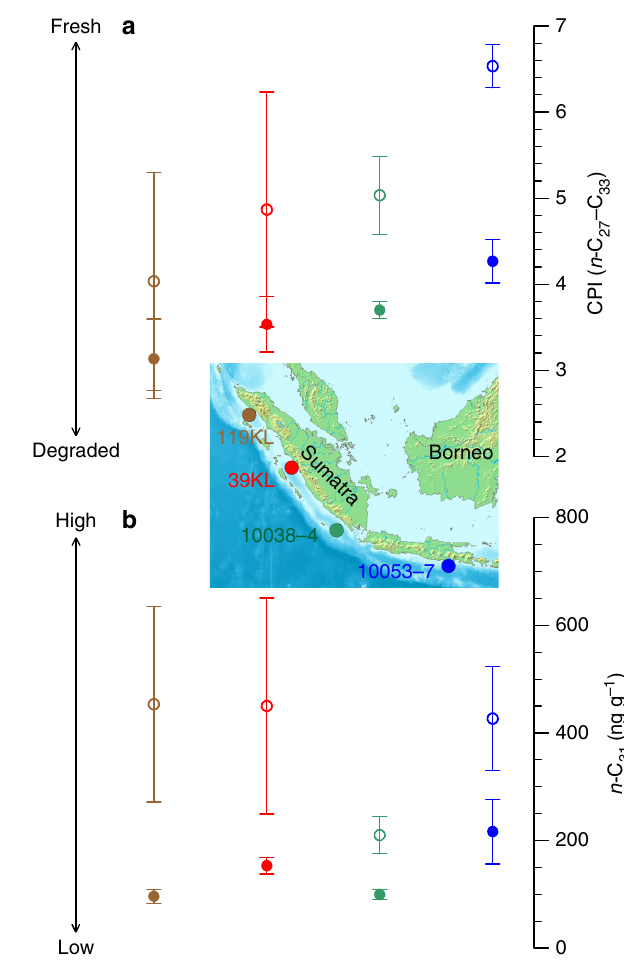
Fig. 3 Late Holocene and LGM concentration of n -alkanes and the CPI values in the eastern tropical Indian Ocean. a , b Filled and open circles represent average values for the late Holocene and the LGM, respectively. Vertical bars indicate 1 σ standard deviation. Note that at all sites, the LGM is characterized by higher sedimentary concentrations of less degraded plant